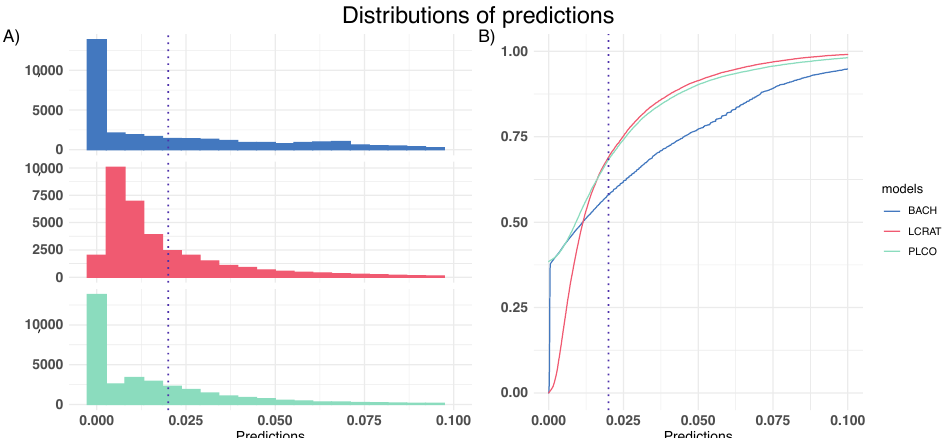
Figure 1. ( A ) Distribution of predictions for the lung cancer risk models. ( B ) Cumulative distribution for three lung cancer risk models presenting the cumulative percentage of predictions. Vertical dotted lines indicate 2%